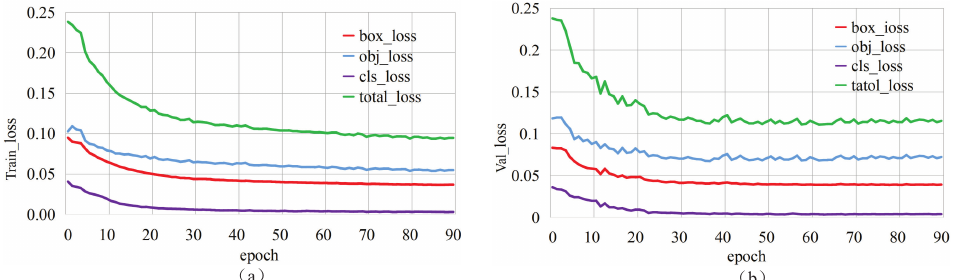
Figure 9. Loss curves of the modified YOLOv5 model during the training process: ( a ) Training set; ( b ) Validation set.